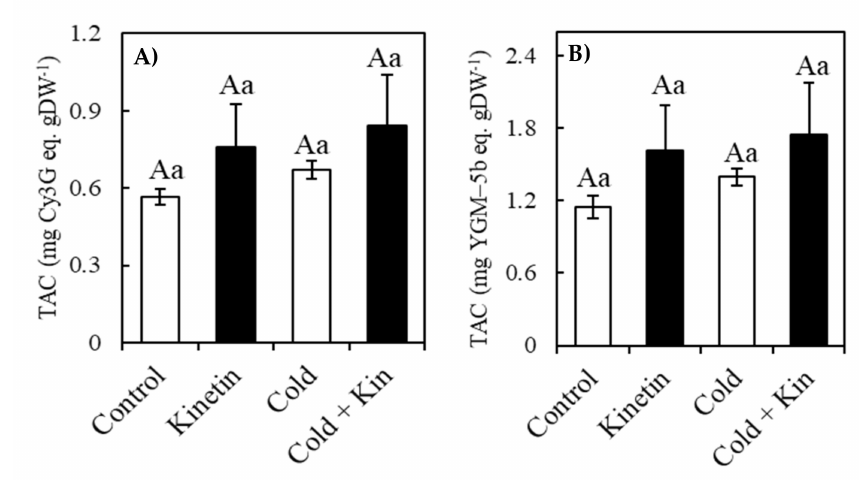
Figure 4. E ff ect of exogenous kinetin on total anthocyanin content (TAC) expressed on the basis of both peonidin-3-(6-ca ff eoyl-sophoride)-glucoside ( A ) and cyanidin 3 glucoside ( B ) in the leaves of the co ff ee plants under optimum and cold stress conditions. Kin, kinetin. Treatment means followed by the same capital letter, (A) are not statistically significantly di ff erent between the temperature treatments, whereas treatment means followed by the same small letter, (a) are not statistically significantly di ff erent between the kinetin treatments ( p < 0.05, Newman–Keuls test). Means are a replicate of three independent samples ( n = 3). Error bars represent standard deviation of the